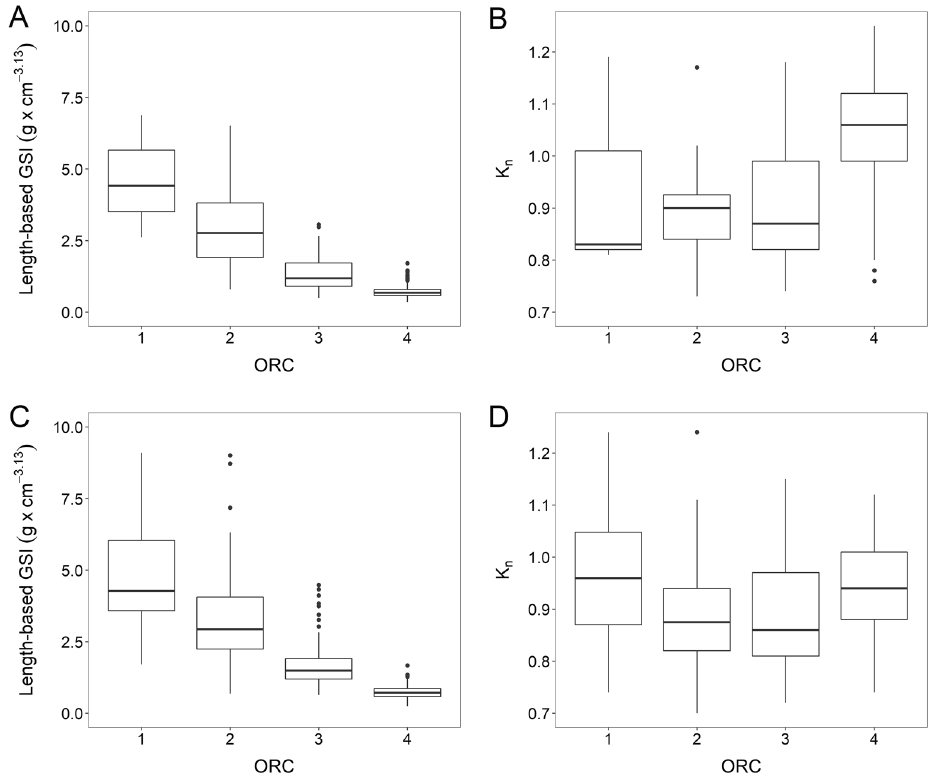
Figure 3. Length-based gonadosomatic index (GSI TL ) ( A and C ) and relative condition (K n ) ( B and D ) as a function of "stage of spawning", represented by ORC. Top panels ( A and B ) represent samples collected and analysed in wholemount in 2018, and bottom panels ( C and D ) in 2019. For each box plot, the thick line is the median value, top and bottom lines indicate the 75th and 25th percentiles, respectively, and whiskers indicate maximum and minimum